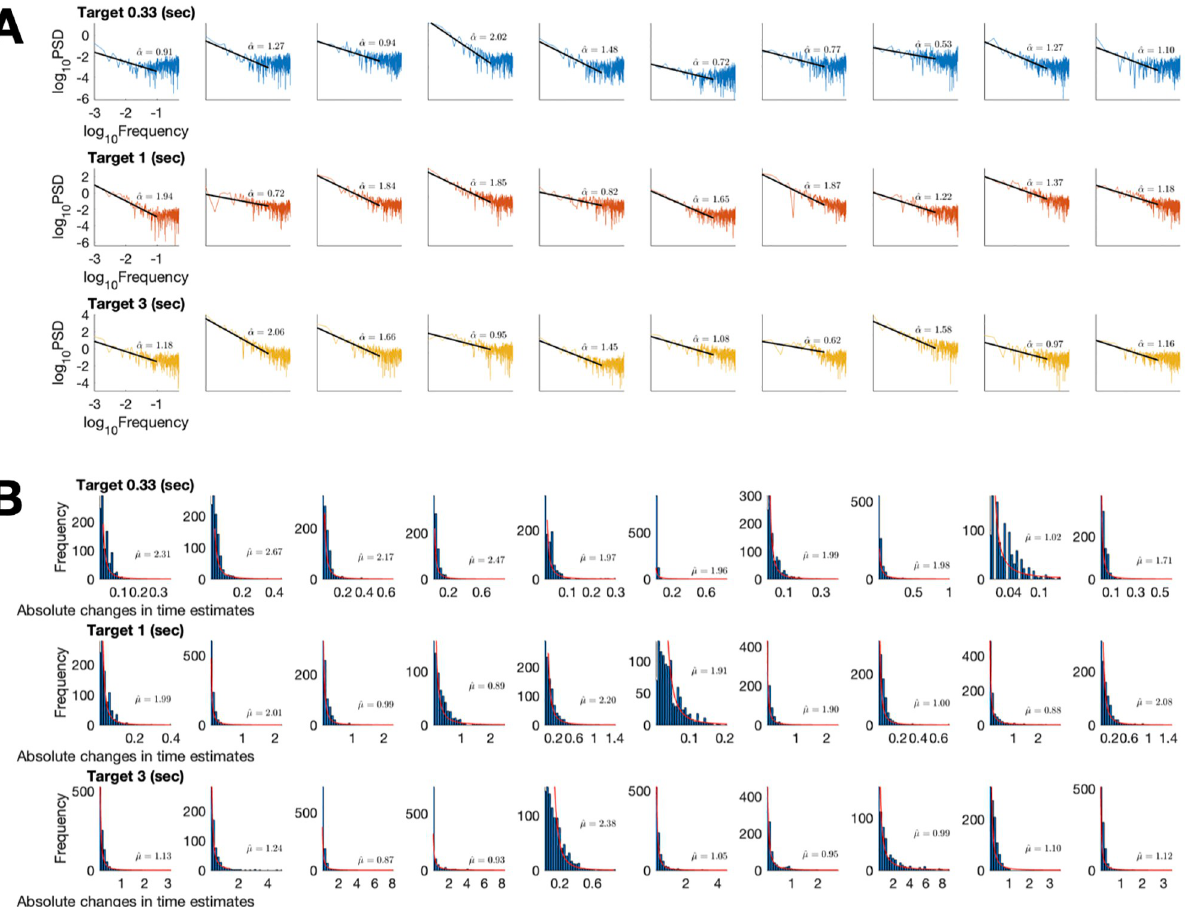
Fig 4. Individual data for the time estimation experiment. (A) Power spectral density. (B) Histograms of absolute changes in time estimates. Fitted lines and curves are overlaid with exponents.